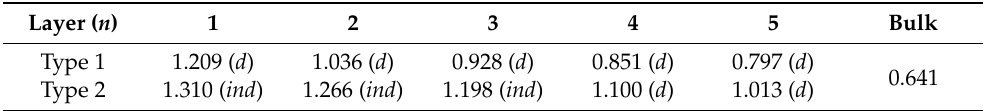
Table 2. Calculated bandgap energies (in eV) of Cs n +1 Sn n Br 3 n +1 and Cs n Sn n +1 Br 3 n +2 ( n = 1–5). The d and ind in parentheses represent direct and indirect bandgap, respectively.